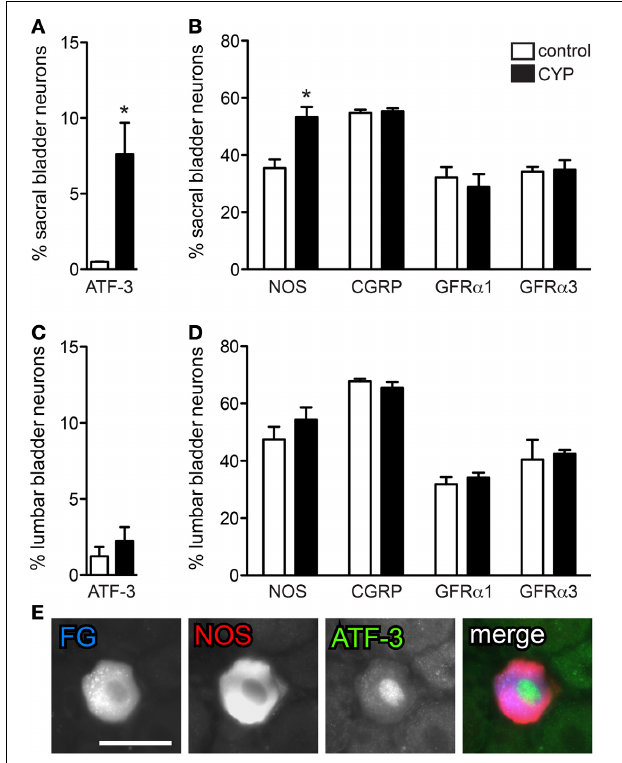
FIGURE 4 | Acute bladder inflammation induced ATF-3 and increased NOS-IR in sacral bladder sensory neurons. (A) Acute cyclophosphamide (CYP) treatment caused a small, but significant induction of ATF-3 in sacral bladder sensory neurons ( ∗ P = 0 . 03). (B) In sacral DRG, acute CYP treatment increased the proportion of FG-labeled neurons containing NOS-IR ( ∗ P = 0 . 01) but did not affect the prevalence of CGRP-, GFR α 1-, or GFR α 3-IR bladder sensory neurons. (C) In lumbar DRG, CYP treatment did not affect the proportion of lumbar bladder sensory neurons containing ATF-3. (D) Acute CYP treatment did not affect the proportion of lumbar bladder sensory neurons with NOS-, CGRP-, GFR α 1-, or GFR α 3-IR. (E) Approximately 80% of ATF-3-IR nuclei were found in NOS-IR neurons. Data represents the mean ± s.e.m. ( n = 3), analyzed by a paired t -test on arcsine-transformed data. Images are shown as monochrome image pairs and the merged image. The color of each label in the merged image is indicated by the color of the text in the relevant monochrome image. Scale bar in the first panel (left) represents 30 μ m and applies to all images.